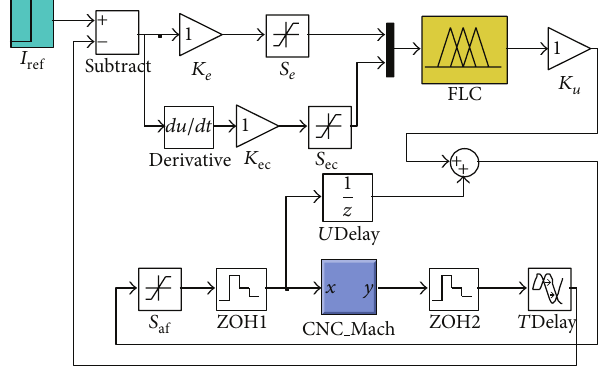
Figure 1: Structure of the fuzzy cutting force control